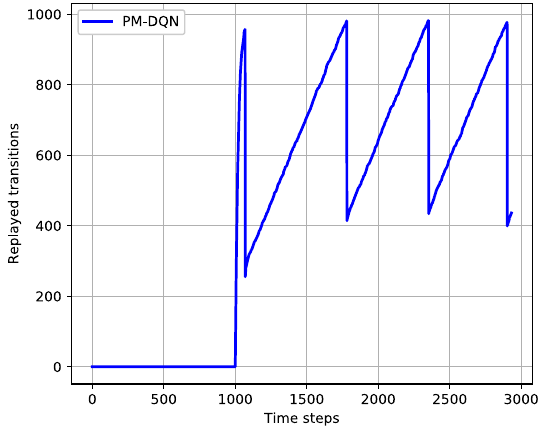
Figure 4. Implementation of Prioritized Memories.